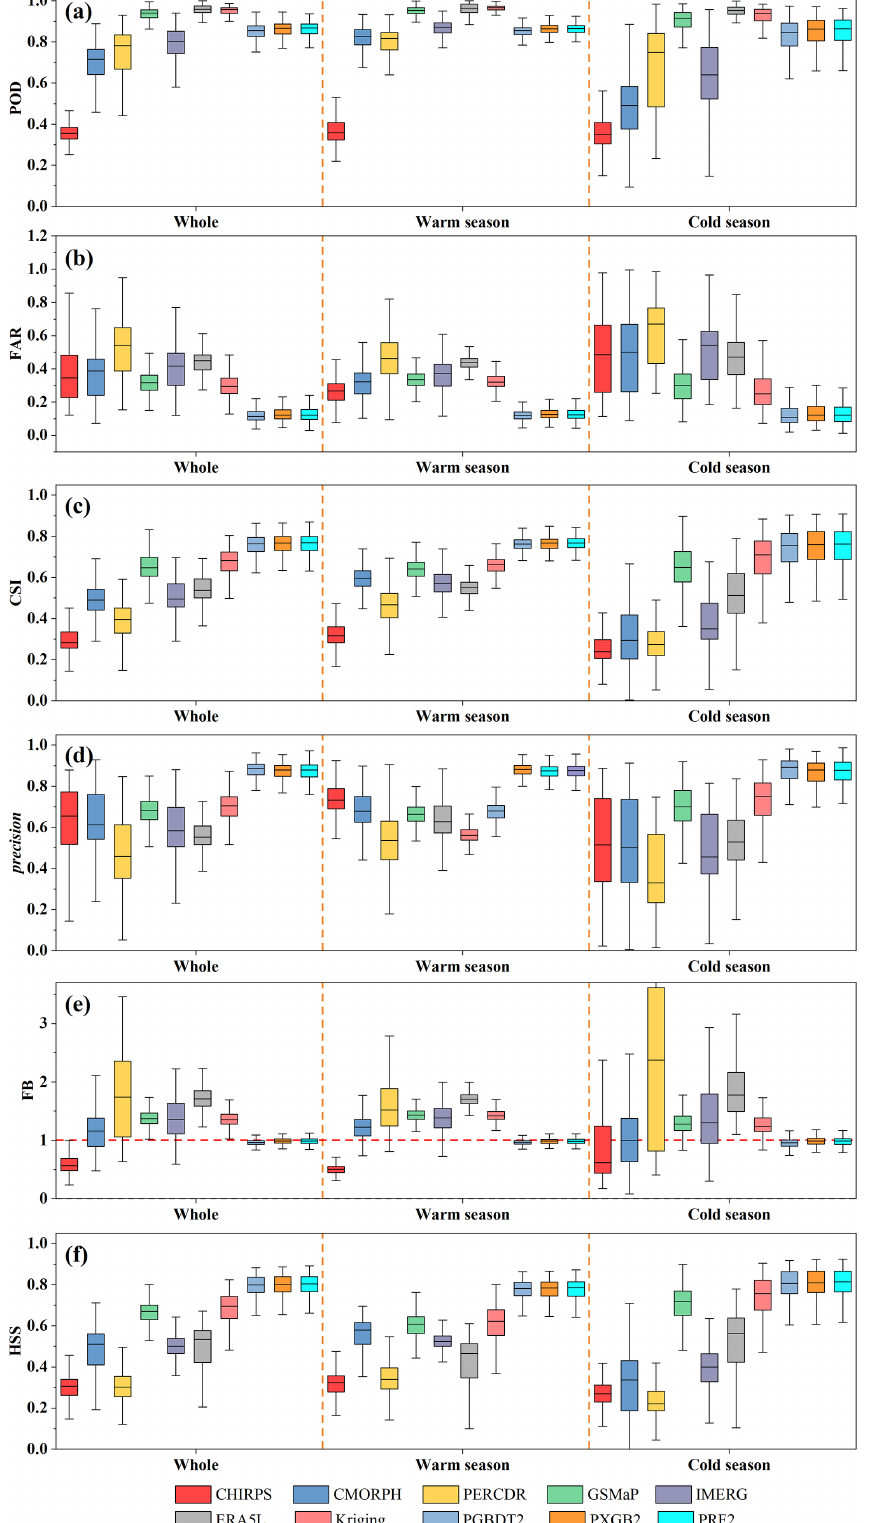
Figure 5. Boxplots of six categorical metrics (POD (a) , FAR (b) , CSI (c) , precision (d) , FB (e) , and HSS (f) ) for 10 products, including six MSPs, one gauge-based interpolated data, and three ML-based merged